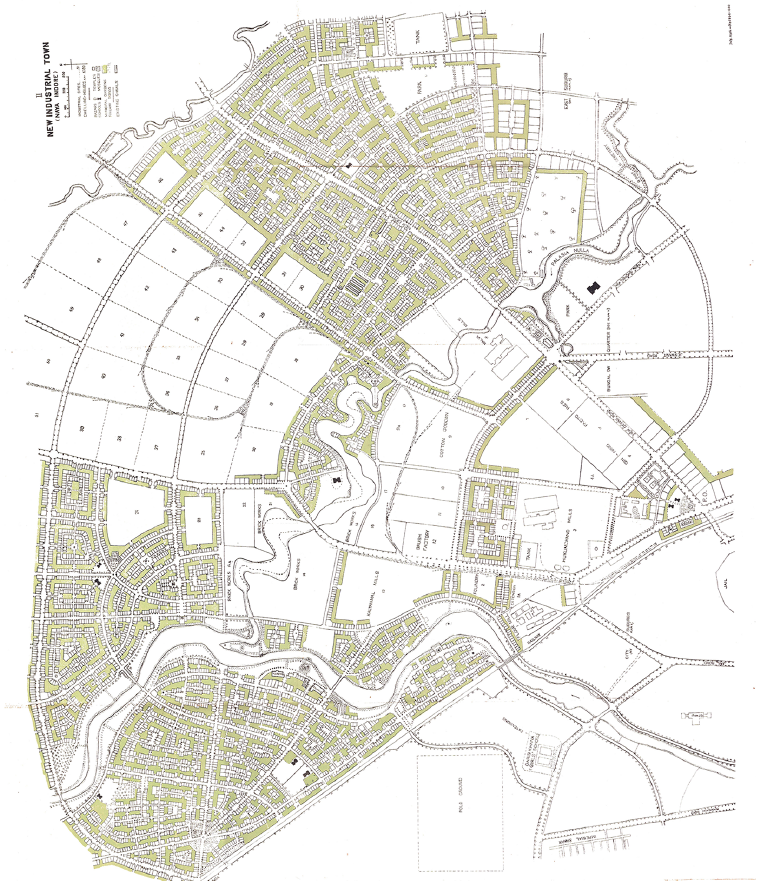
Figure 5. Indore urban block explorations. Source: Geddes